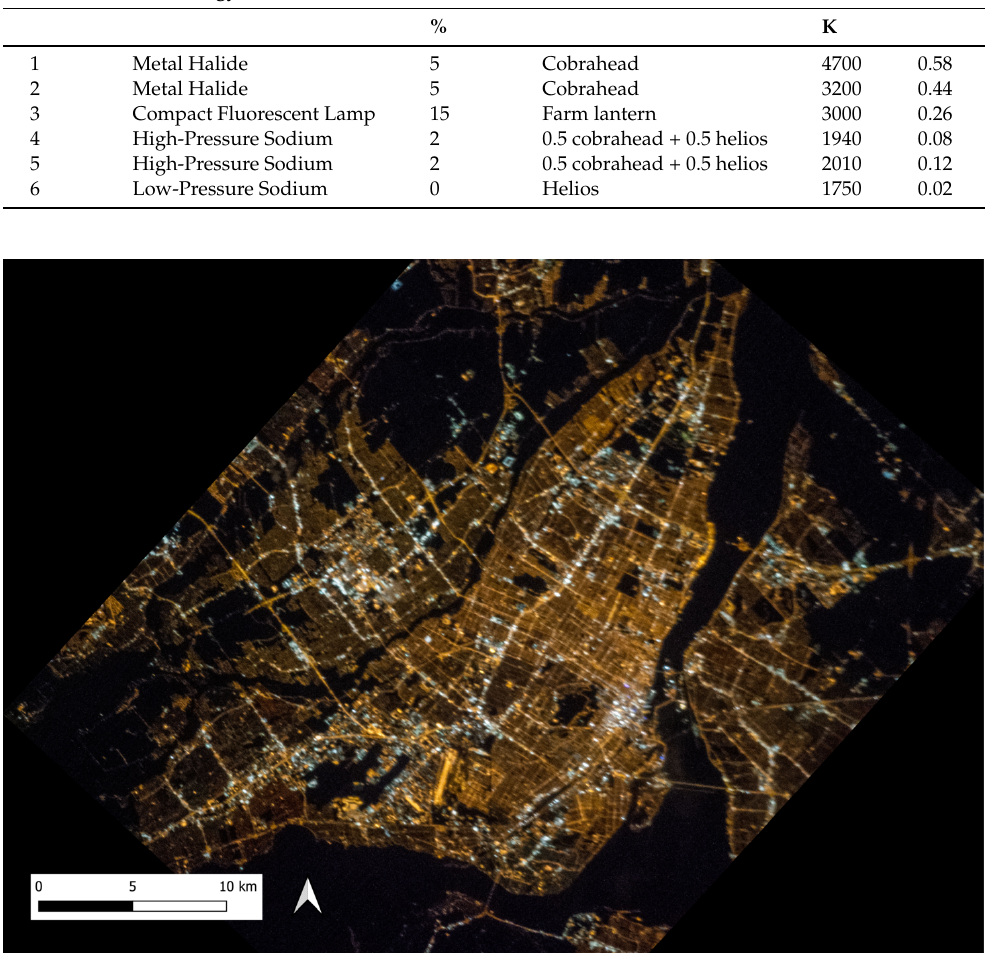
Figure 1. Georeferenced image of Montréal from the ISS taken on 6 April